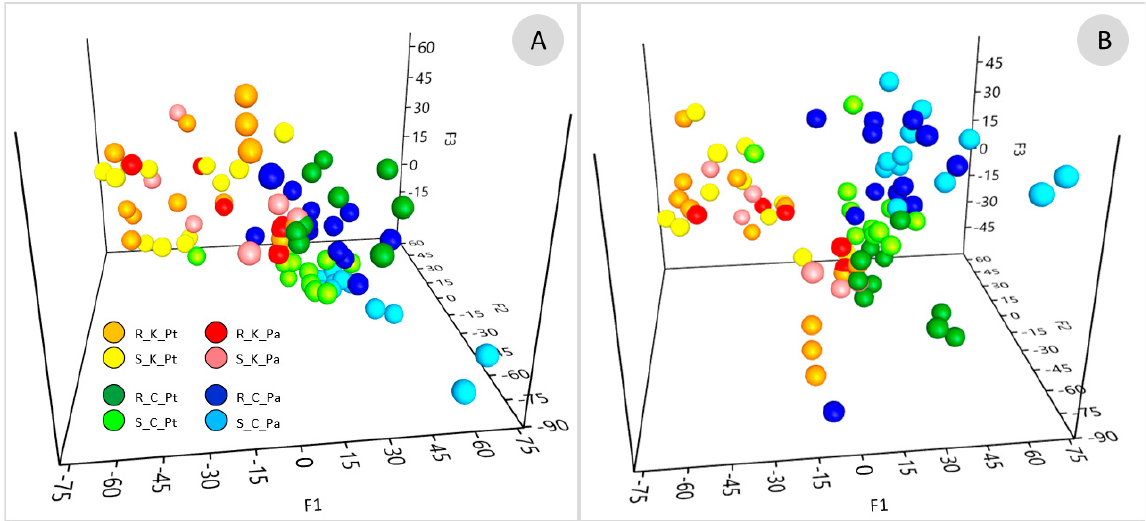
Figure 5. The ordination based on placement-factorization showing the distribution of root (R) and soil (S) AMF communities associated with P. trivialis (Pt) and Ph. australis (Pa) at the contaminated (K) and the uncontaminated site (C). Placement-factorization indicates the relationship between changes in the abundance of clades in the phylogenetic tree and changes is soil-physicochemical features assessed by the generalized linear model (GLM). Axes represent the balances of the winning edges of the first three phylofactors (F1, F2 and F3, Figure S5). Placement-factorization was performed considering only phenol and PAH contamination ( A ) and with all meta-data (phenol and PAH contamination, Ntot, SOM, pH KCl pH H 2 O, moisture) ( B ).